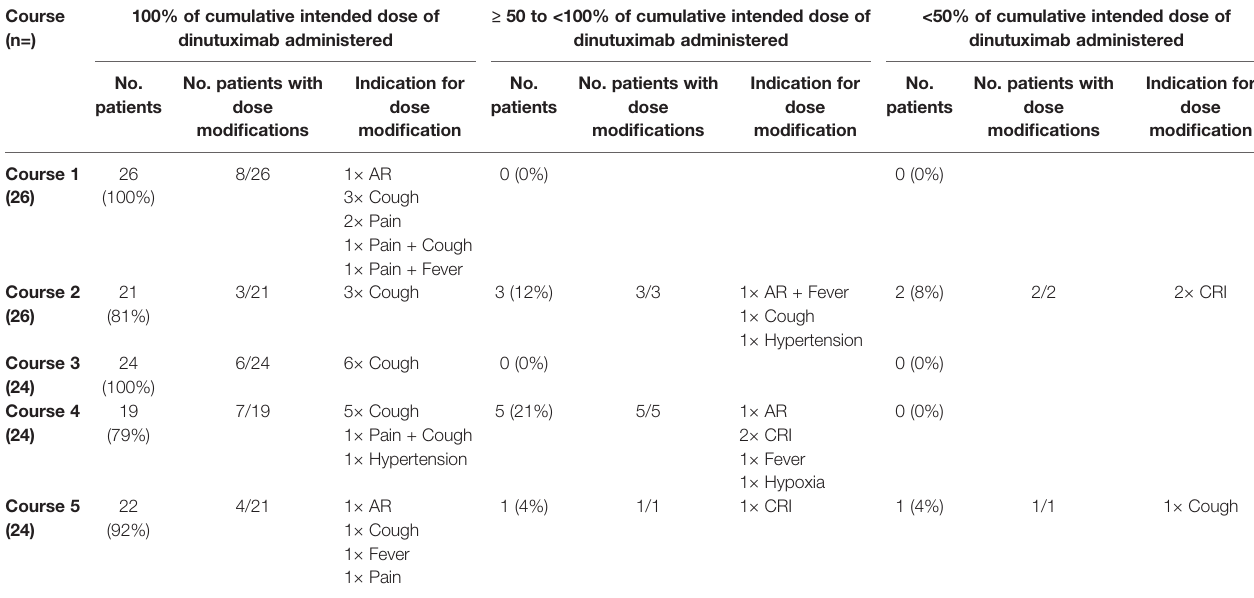
TABLE 4 | Immunotherapy-related toxicities leading to dose modi fi cations of dinutuximab. Course 100% of cumulative intended dose of (n=) dinutuximab